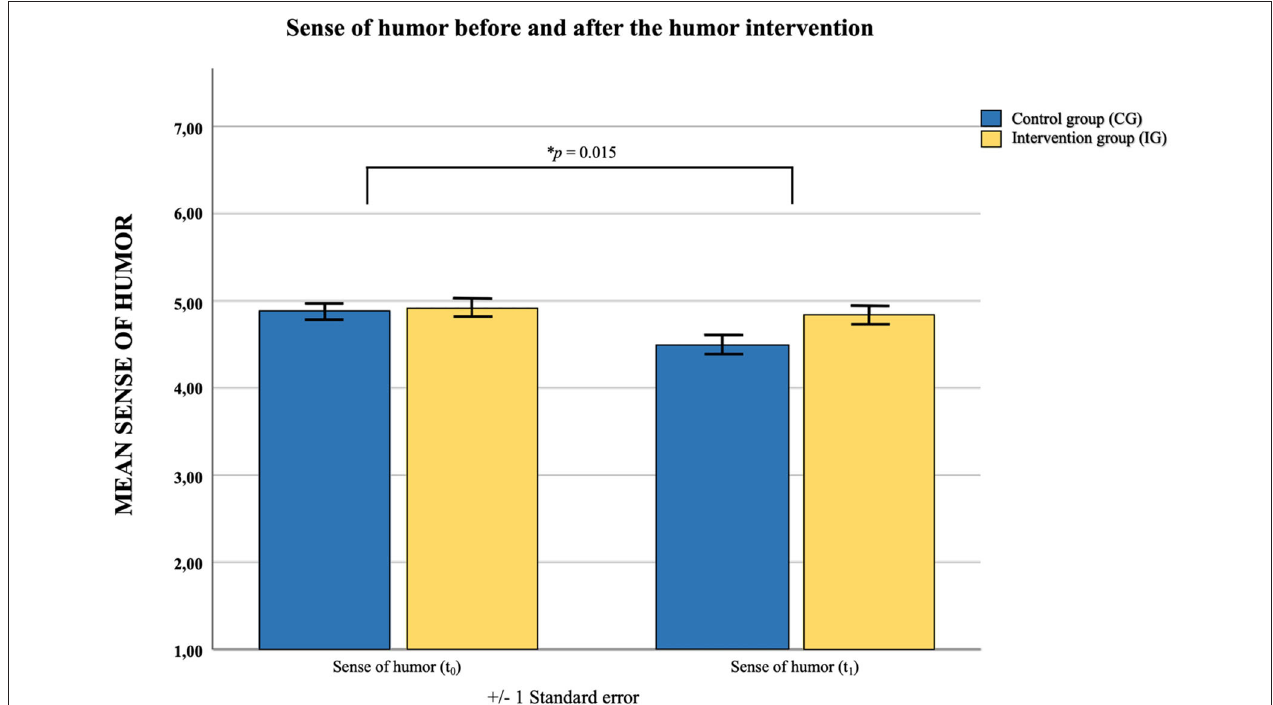
FIGURE 3 | Sense of humor before and after the humor intervention comparing control group (CG) and intervention group (IG); Measuring points: t 0 = Baseline; t 1 = 6 months after the humor intervention; the interaction effect ( p = 0.015) indicated that sense of humor decreased from t 0 to t 1 in the control group, but remained stable in the intervention group.